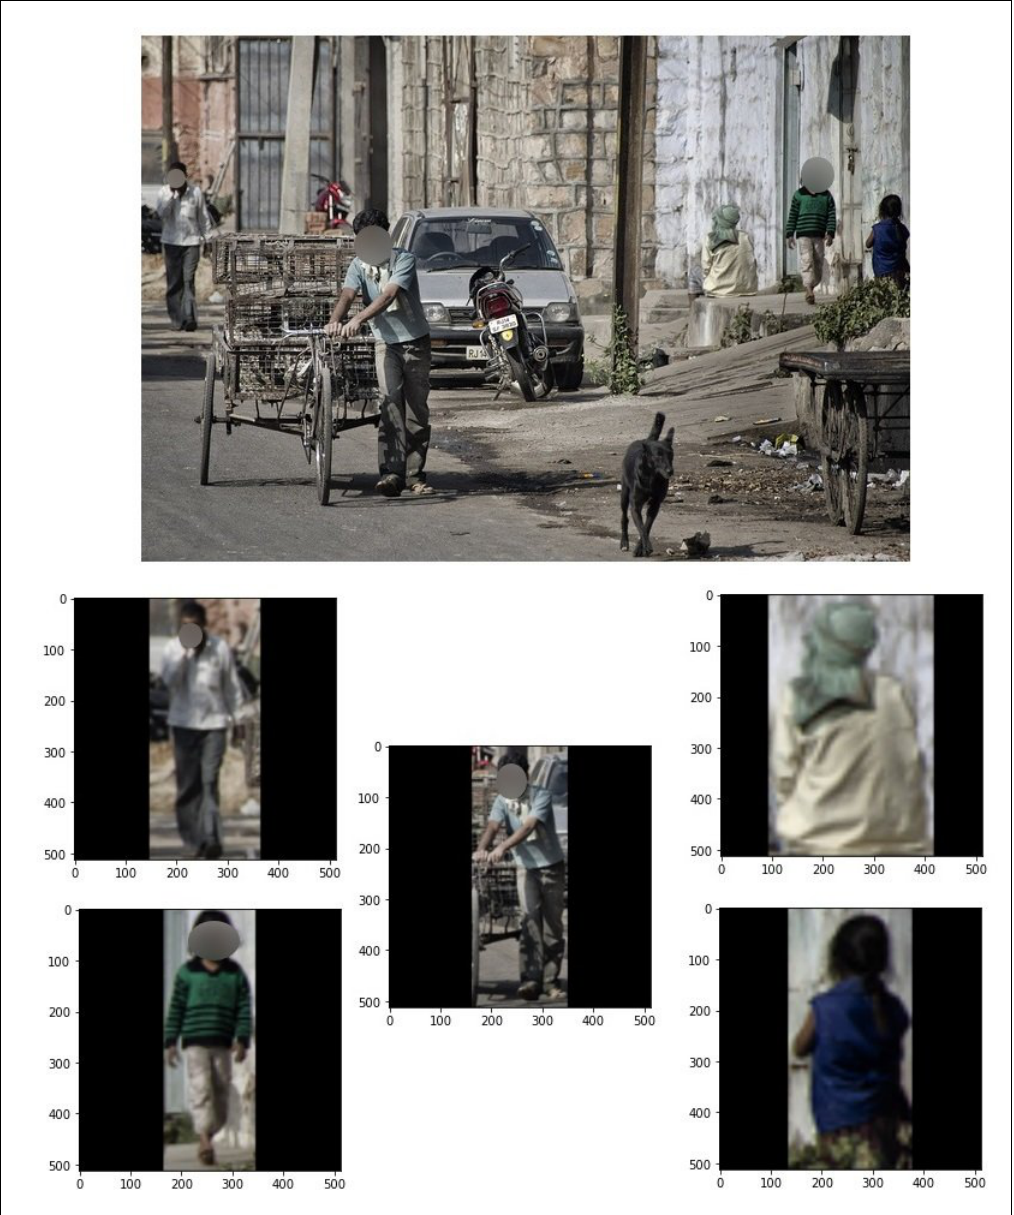
Figure 3. Example of a processed image after submission of the region of interest recognition